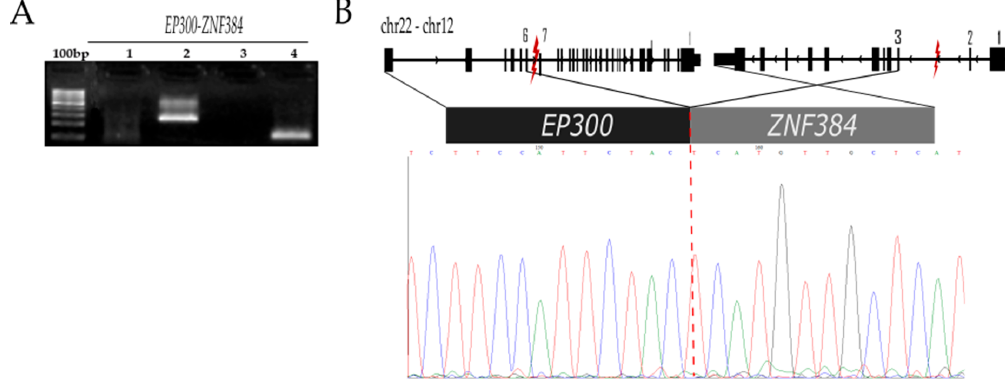
( B ) Schematic representation of the localization of the breakpoints within ETV6 and NUFIP1 and the corresponding result of sequencing where exon 1 of the ETV6 gene and exon 6 of the NUFIP1 gene are fused together in this transcript. ( C ) Schematic representation of ETV6-SNUPN where exon 2 of the ETV6 gene and exon 2 of the SNUPN gene are fused. The symbol “lightning” indicates the breakpoint region.